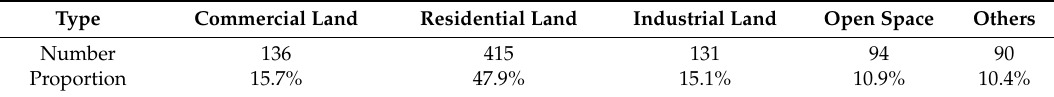
Table 1. Urban functional zone (UFZ) types and grid numbers of each